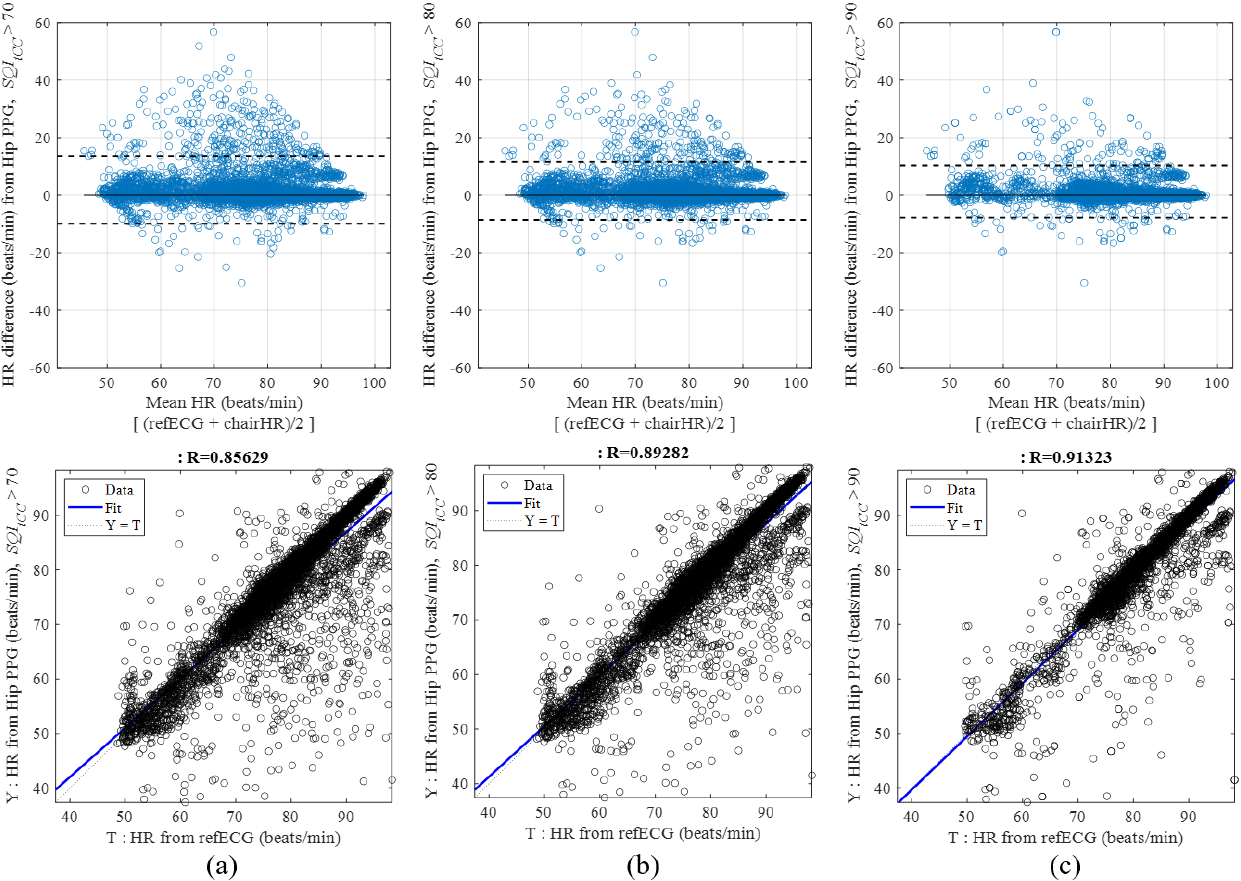
Figure 7. Bland–Altman and linear regression plots of HRs from the reference ECG signal and from the cPPG signals detected at the hip after screening by each SQI atCC criterion: ( a ) SQI atCC > 60%; ( b ) SQI atCC > 70%; ( c ) SQI atCC > 80%.